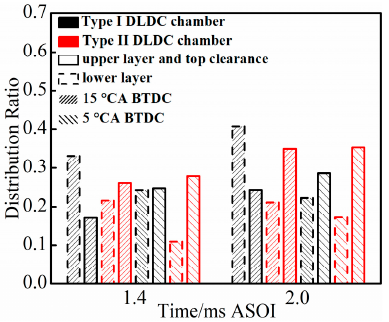
Figure 22. The layer fuel spray distribution ratio at different times with a Ф 0.18 mm nozzle, 150 MPa injection pressure and different injection timings.